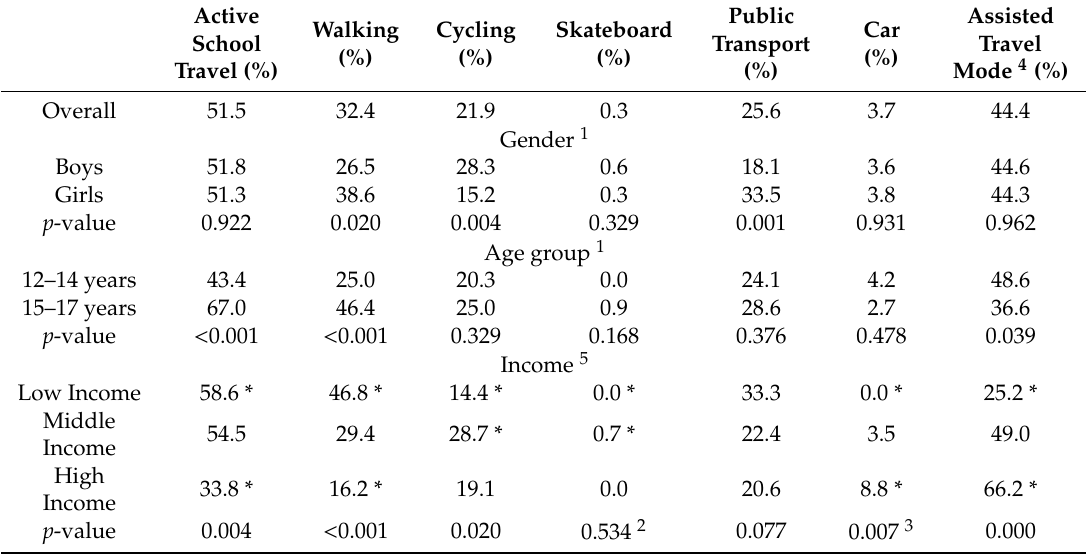
Table 1. Adolescents’ self-reported travel mode to or from school ( ≥ 1 trip / week)—overall, by gender, age group and income ( n =